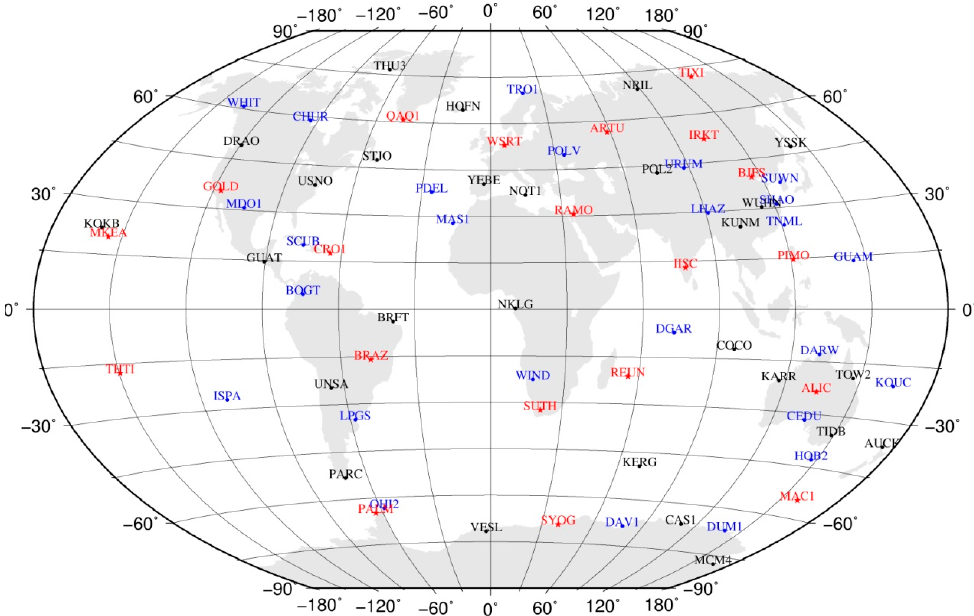
Figure A1. Location map of the globally distributed 73 IGS stations which are generally selected from the core network of IGb08 reference frame (ftp://igs.org/pub/station/coord/IGb08_core.txt). The black and blue dots indicate two subnetwork stations, respectively. The red pentagrams indicate the common stations of these two subnetworks.